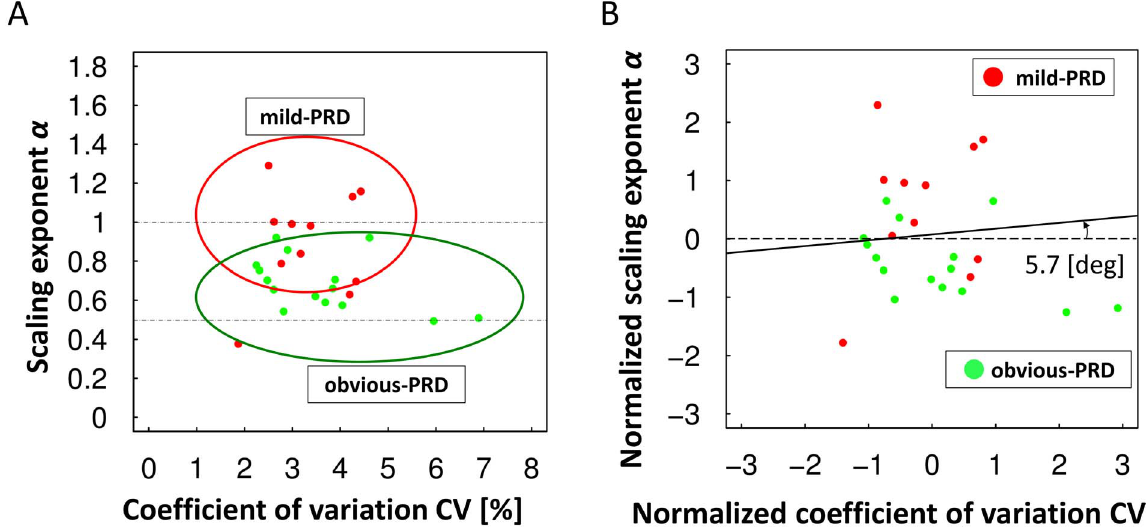
Figure 4. Classification of obvious and mild postural reflex disorder. The mild postural reflex disorder group (mild-PRD) is indicated by red points, and the obvious postural reflex disorder group (obvious-PRD) is indicated by light-green points. The x-axis represents the CV, and the y-axis represents a . (A) Distribution of the original data. (B) Distribution of the normalized data. The solid line represents the boundary between the mild- PRD and obvious-PRD groups.